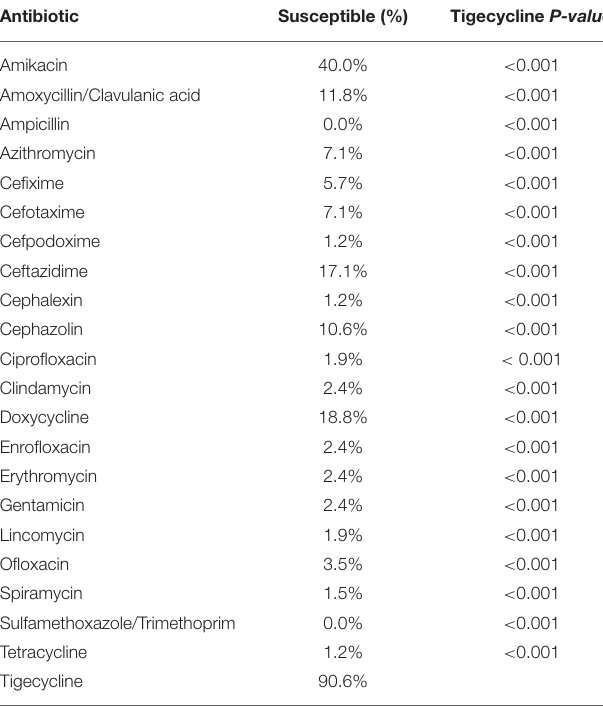
TABLE 4 | Superiority of tigecycline efficacy over 21 different antibiotics to eradicate potential pan-drug-resistant bacteria from dogs. Antibiotic Susceptible (%) Tigecycline